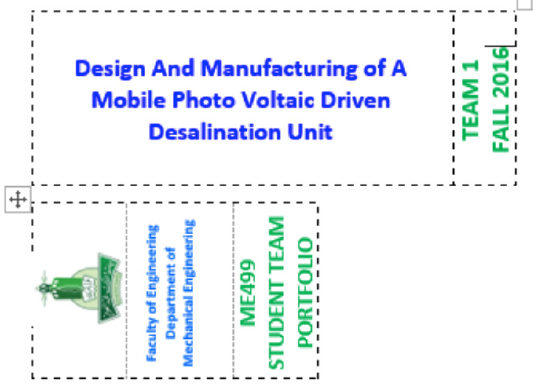
Fig. 5. Sample of the cover for the